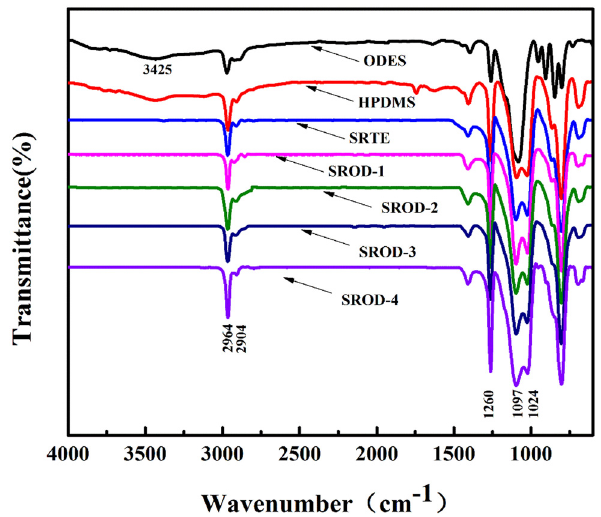
Figure 2: FTIR characterization of ODES, HPDMS ( 107# ) , and RTV silicone rubber ( SRTE, SROD - 1, SROD - 2, SROD - 3, SROD - 4 )